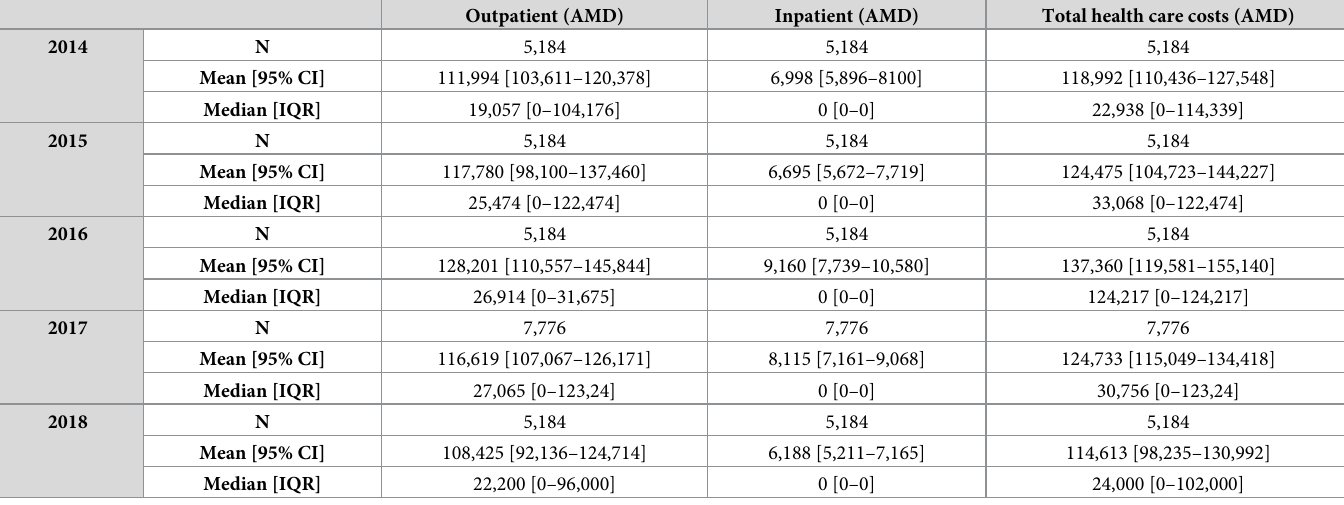
Table 2. Trends in annual OOP payments in Armenia between 2014 and 2018 in Armenian Drams (AMD)– 2018 constant AMD. Outpatient (AMD) Inpatient (AMD) Total health care costs